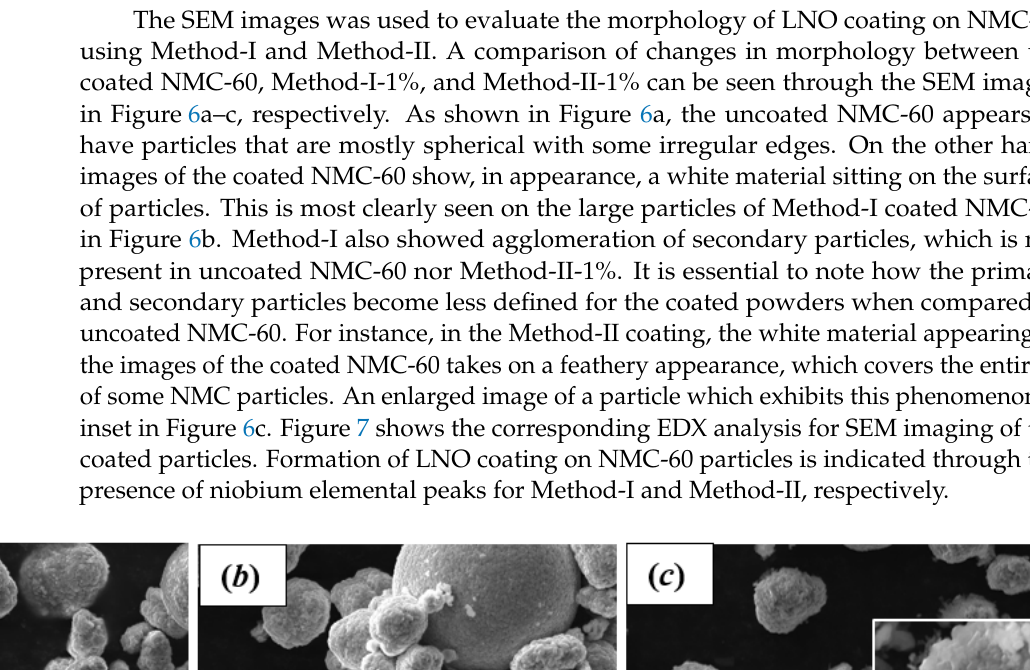
Figure 5. Materials in red circles seem to be the agglomerated LNO with sizes < 1 μ m produced during synthesizing, but has not participated in coating layer formation on the NMC-60 particles.